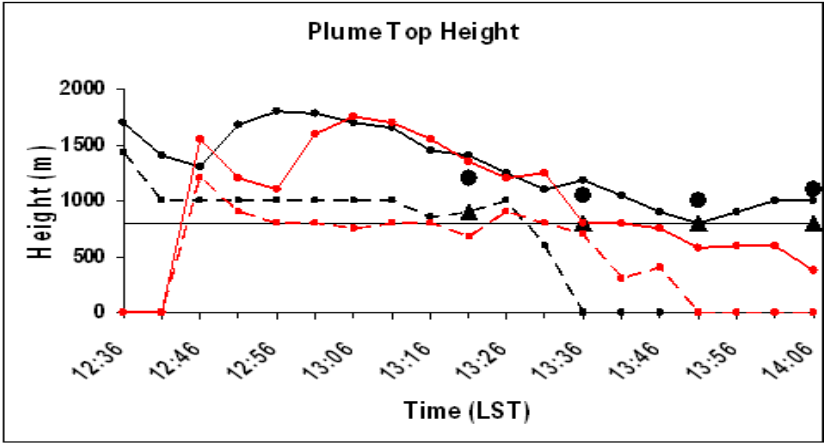
Figure 11. Plume top heights and bases of Daysmoke simulations based on WRF (black lines—solid and dashed) and MM5 (red lines—solid and dashed). The plume data were calculated from Daysmoke at 12.5 km (7.8 mile) downwind from the burn. Plume tops and bases observed by ceilometer are given, respectively, by the large circles and